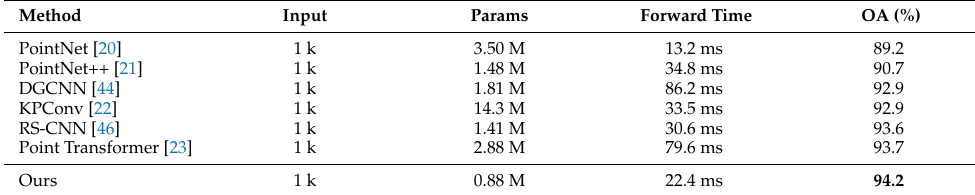
Table 14. Complexity Analysis. The bold denotes the best performance. Method